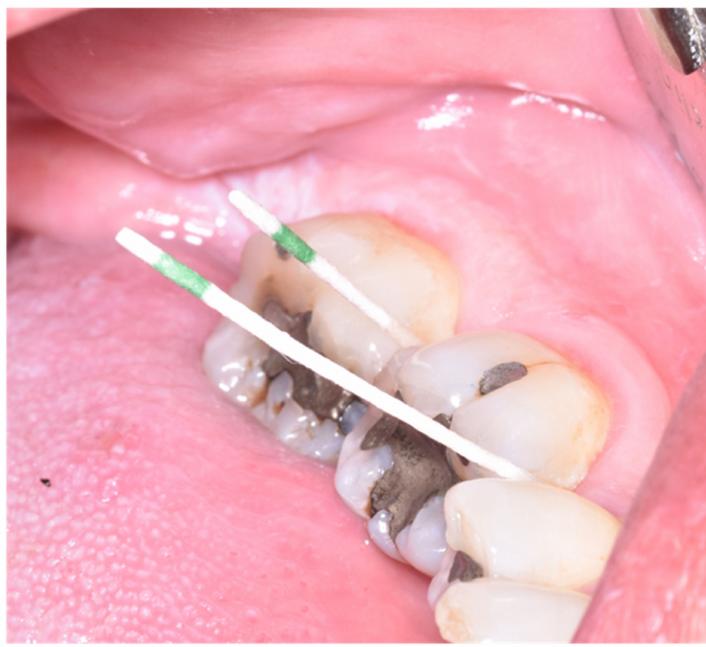
Figure 1. Taking a sample of the subgingival fluid.